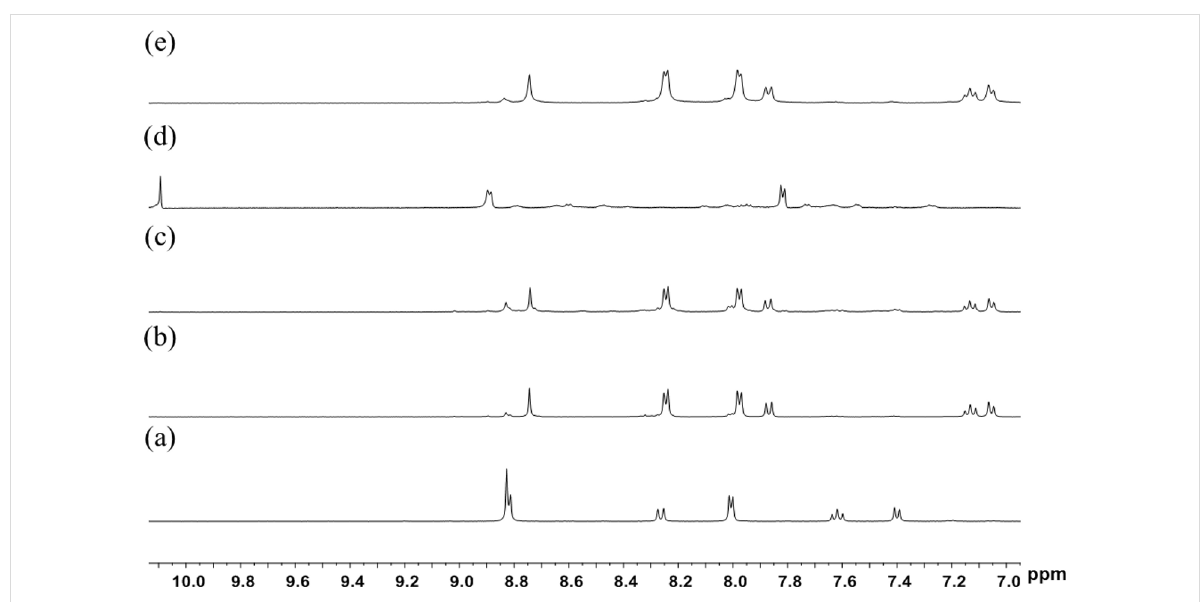
Figure 2: Partial 1 H NMR spectra (400 MHz, DMSO- d 6 , ppm) of (a) L2 ; (b) a sample of metallarectangle 3b obtained by coordination-driven self- assembly of organometallic clip 1 and L2 (method A); (c) a sample of metallarectangle 3b obtained by [4 + 4] condensation reactions of half-sand- wich rhodium-based dialdehyde complex 2 with 1,5-diaminonaphthalene (method B); (d) half-sandwich rhodium-based dialdehyde 2 ; (e) the product of assembly of organometallic clip 1 , 1,5-diaminonaphthalene and 4-formylpyridine in a one-pot procedure (method C).